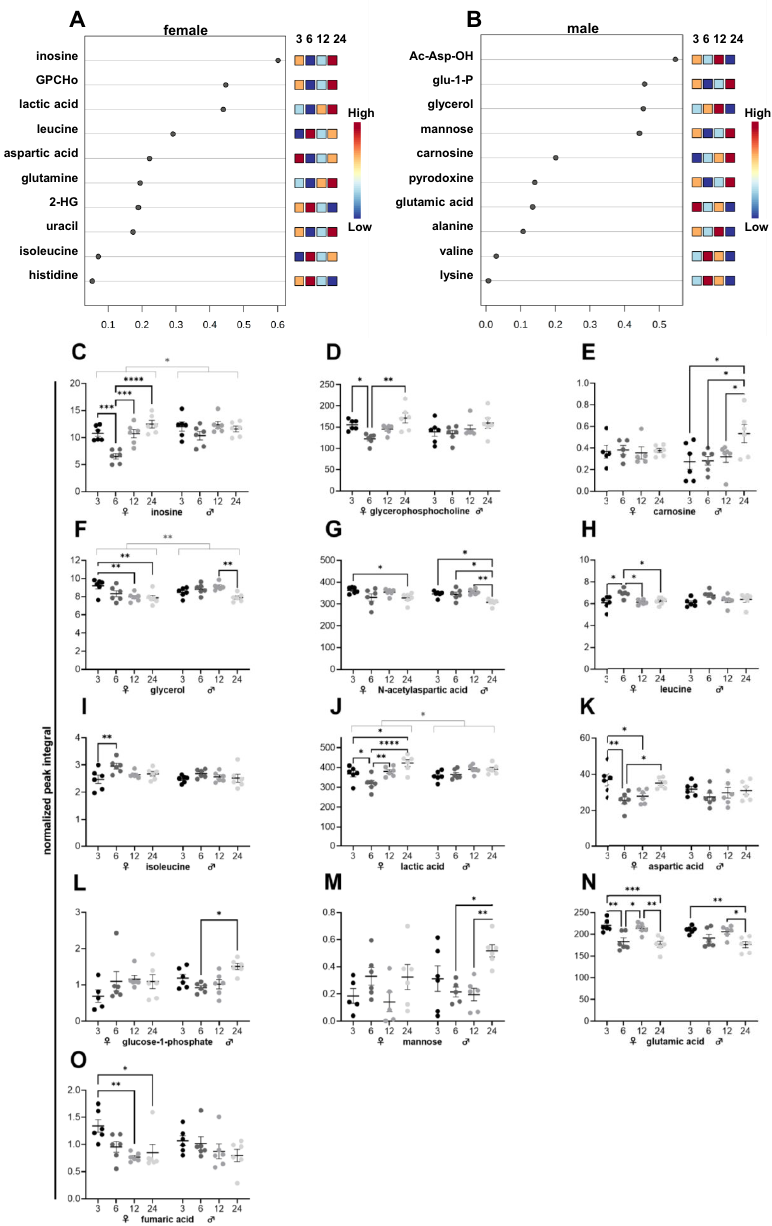
Figure 2. NMR metabolomics of female and male murine brain samples. Metabolites of six female ( A ) and six male ( B ) mice ranked based on the variable importance during projection (VIP) score as a function of age. Individual metabolite levels of female (left) and male (right) tissues at 3, 6, 12, and 24 months presented as normalized peak integral ( C – O ). 2-HG 2-hydroxyglutaryl, Ac-Asp-OH N-acetylaspartic acid, Glu-1-P Glucose- 1-phosphate, GPCho